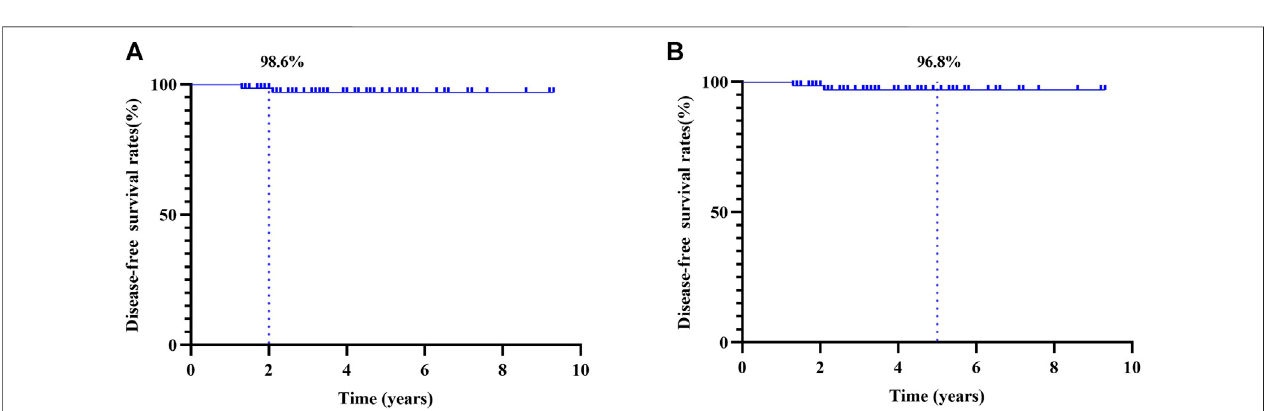
FIGURE 4 | Kaplan – Meier curves for disease-free survival (DFS): (A) 2-year DFS and (B) 5-year DFS.